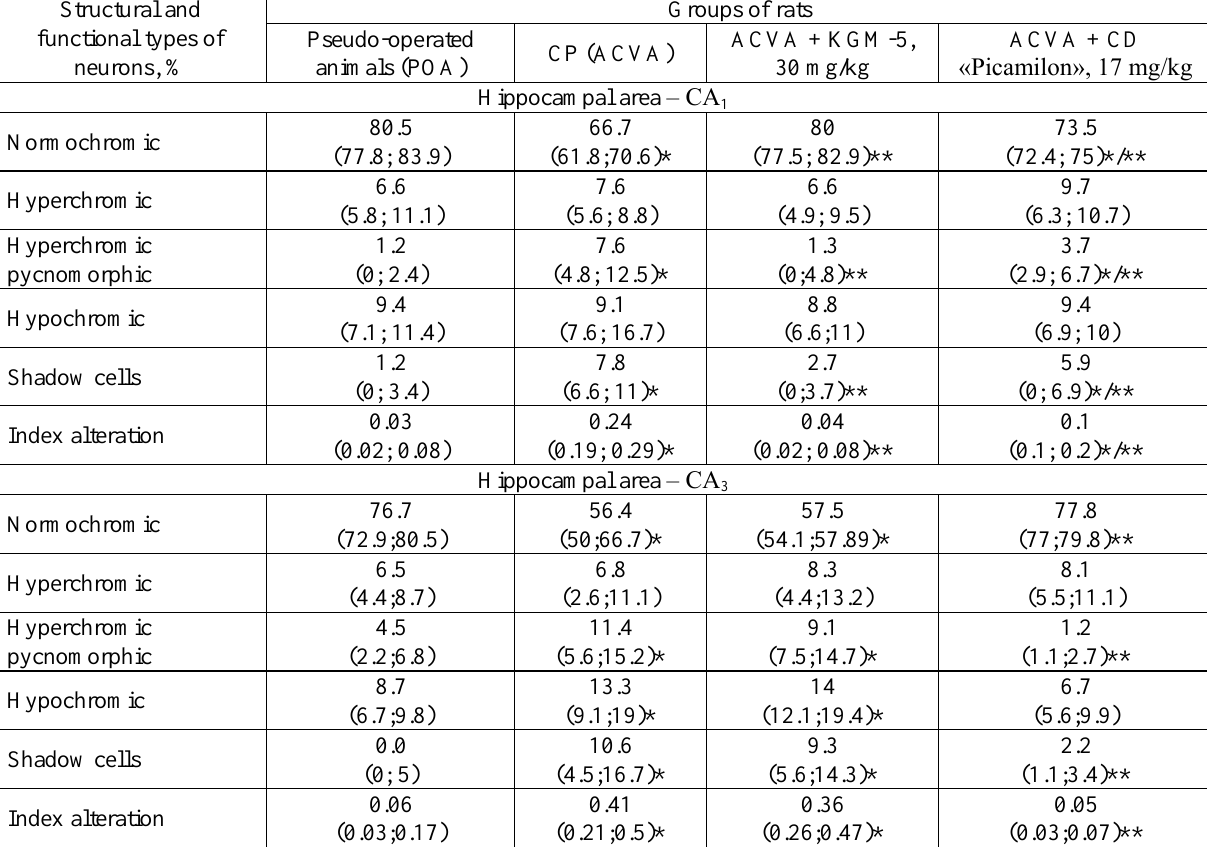
and CA zones of the ventral hippocampus of rats with the 1 3 ACVA model under the influence of the studied